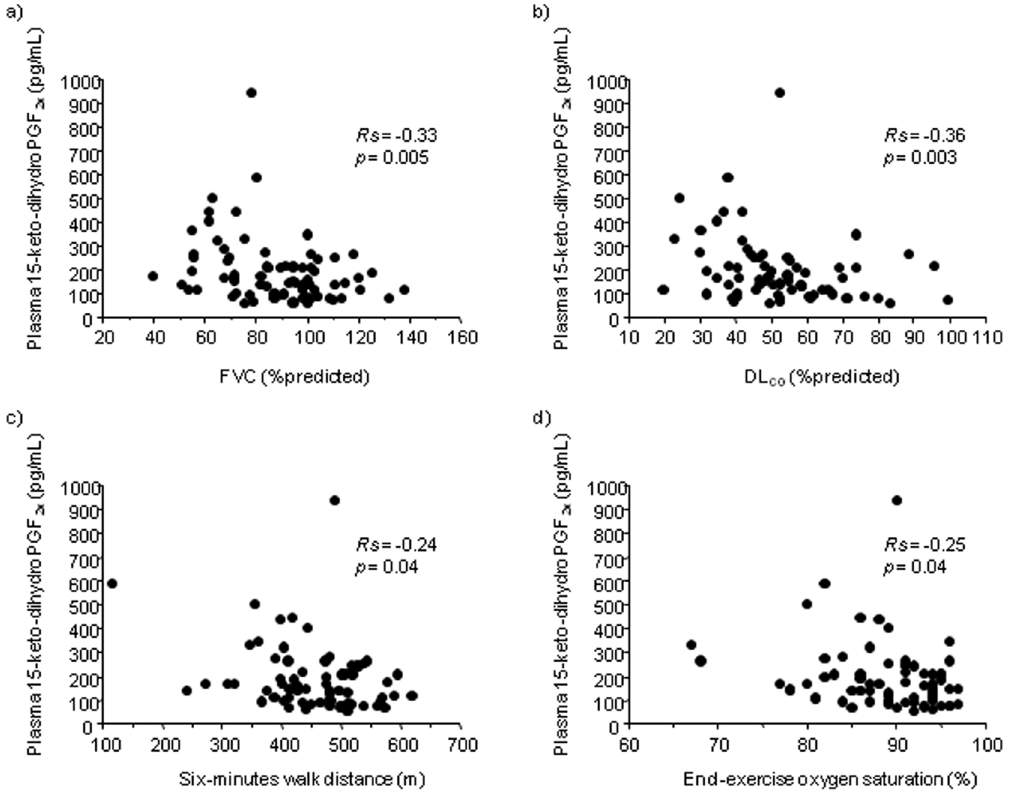
Figure 2. Correlations of plasma 15-keto-dihydro prostaglandin F 2 a concentrations with indices of disease severity. Scatter diagrams show the correlations of plasma 15-keto-dihydro prostaglandin F 2 a concentrations with FVC (a), DL CO (b), six-minute walk distance (c) and end- exercise oxygen saturation (d) in IPF patients without emphysema. The Rs value indicates the correlation coefficient.